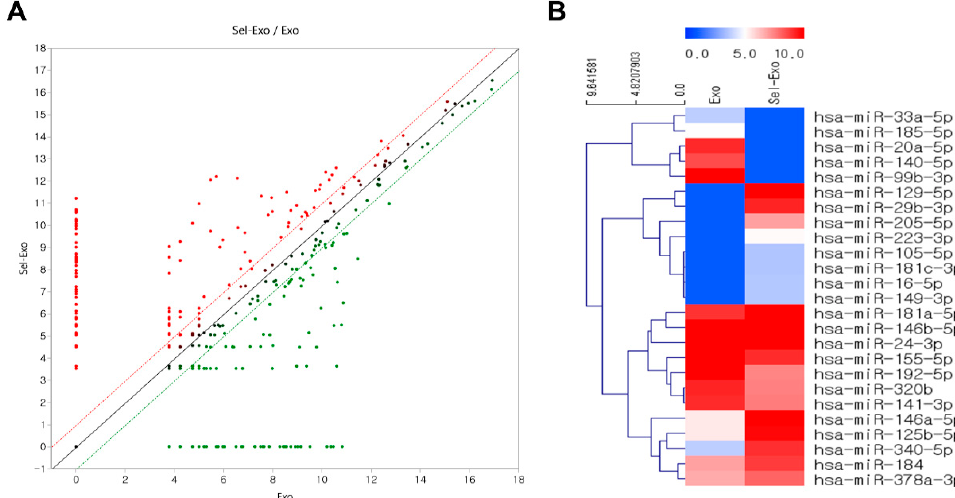
Figure 7. Distribution of differentially expressed selenium-treated exosomes compared to exosomes. ( A ) Scatter plots show the differential miRNA expression between two samples. ( B ) Hierarchical clustering analysis indicates organized miRNA expression in wound repair.